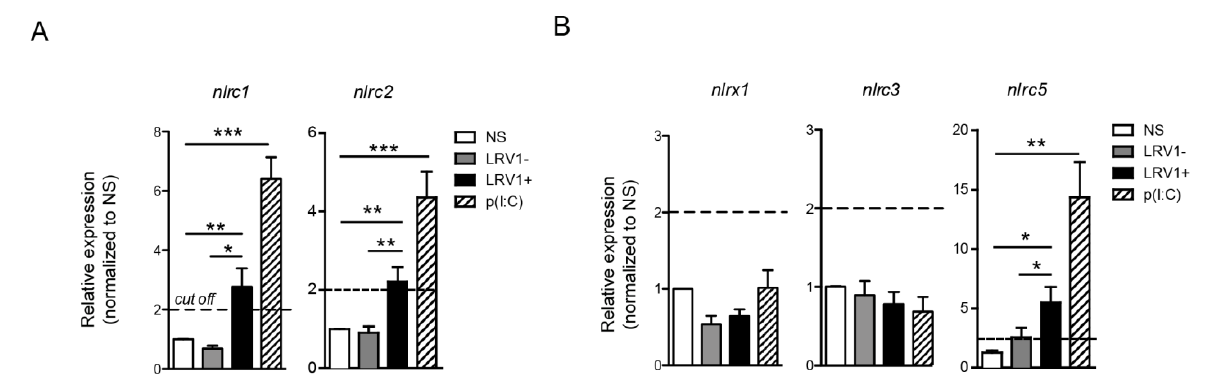
FIGURE 6: LRV1 induces the expression of inflammasome-independent NLRs: NLRC2 and NLRC5. (A-B) BMDMs from C57BL/6 mice were infected with LgyLRV1+ or LgyLRV1- parasites or stimulated with a synthetic TLR3 ligand, poly(I:C). After 6 hours, mRNA was quantified by qRT-PCR for NLRC1 and NLRC2 (A) or for NLRC5, NLRX1 and NLRC3 (B) . The bar graphs are representative of at least 3 independent experi- ments, using 2 technical and 2 biological replicates, and showed as mean ± SEM. Non-parametric Student’s t -test was performed. *p < 0.05, **p < 0.01, ***p < 0.001. A cut off value of 2-fold was shown as a dotted